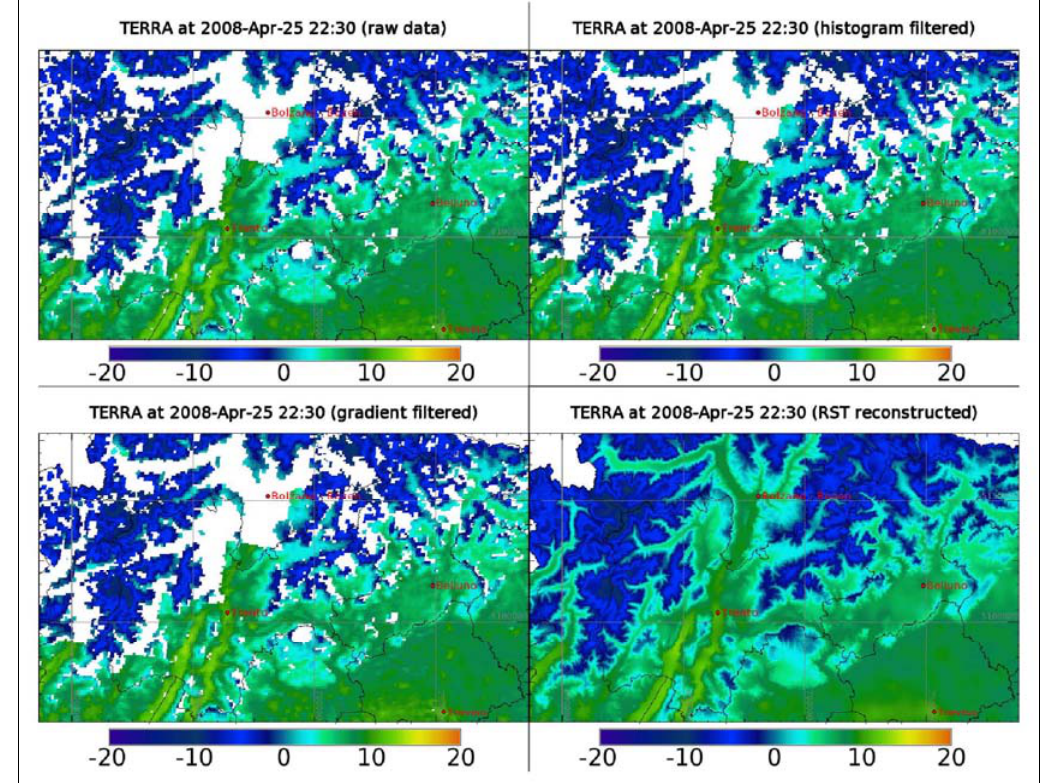
Figure 5. Spring MODIS LST night map reprocessing (25 April 2008 at 22:30 hs, all maps in UTM32/WGS84 metric grid, map scale 1:2,600,000): Raw LST map (upper left), map outliers filtered via histogram (upper right), outliers filtered via gradient (central left), volumetric splines reconstructed (RST, central right), difference map between the raw and RST maps (lower left), scatter plots of raw (black), histogram & gradient filtered (yellow) and RST (green) maps including linear regression gradients (lower right). For explanations, see